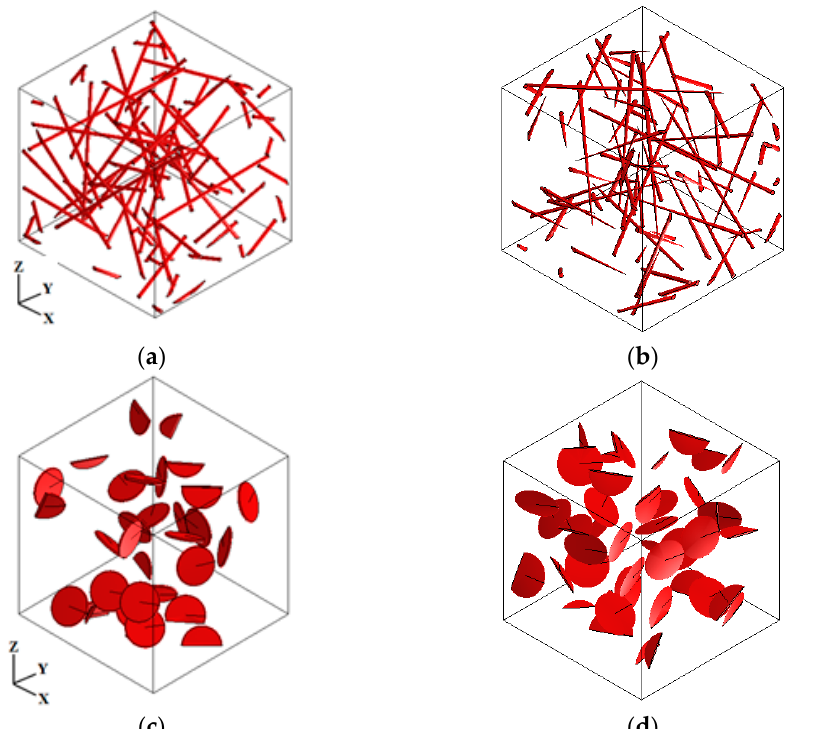
Figure 3. RVE of random CNT and GNP nanofillers: ( a ) CNT cylindrical inclusion; ( b ) CNT ellipsoidal inclusion; ( c ) GNP platelet inclusion; and ( d ) GNP ellipsoidal inclusion.